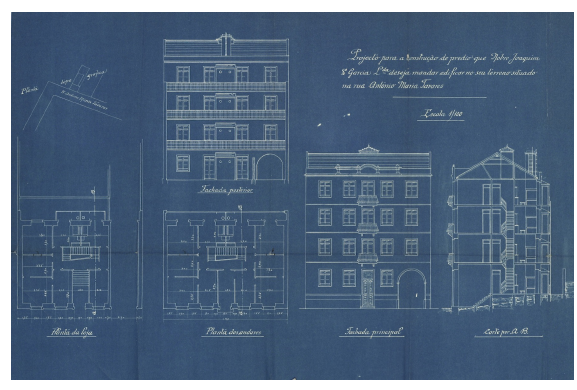
Figure 6. Original project (Lisbon Municipal